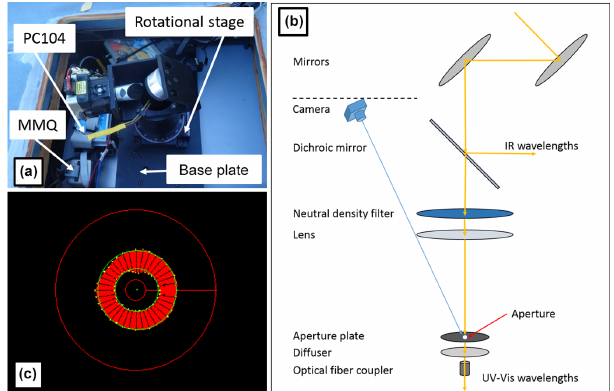
Figure 2. Instrumental setup during FRAPPE 2014. (a) The digital solar tracker mounted inside the roof hatch of the mobile laboratory; (b) optical schematic of the solar tracker; (c) processed image of the solar disk on the aperture plate showing fitted circles (green). The red circles show search region for circle fitting